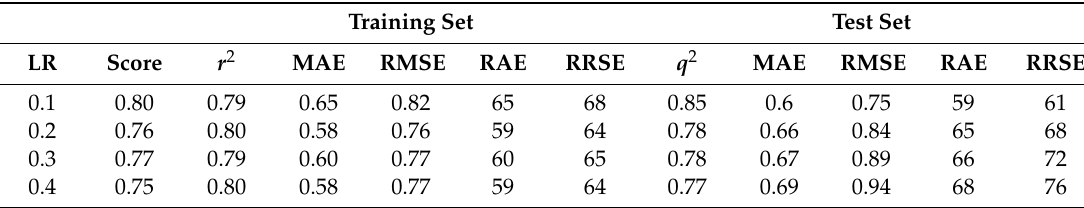
Table 1. Performance of the ANNs as a function of the learning rate. Training Set Test Set